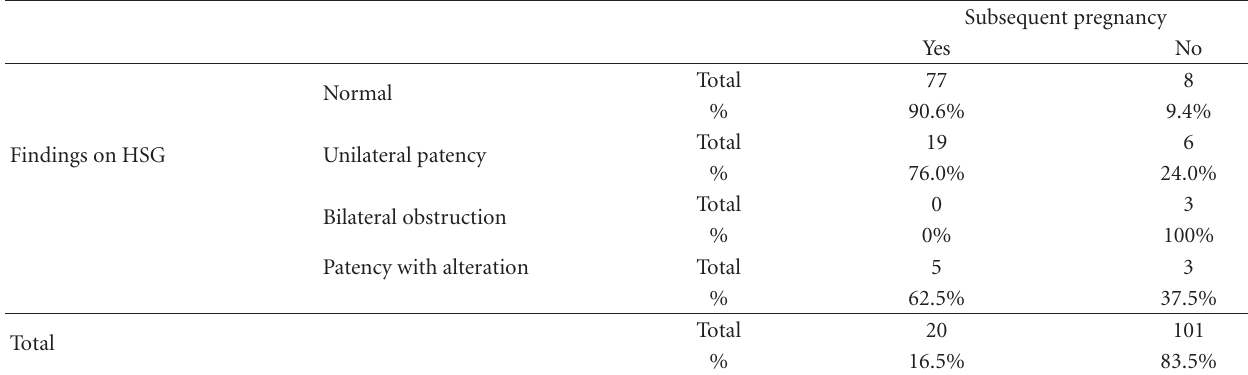
Table 4: Accomplishment of subsequent pregnancy according to the findings on hysterosalpingography (HSG). Results are expressed as frequencies and percentage ( P < 0 .